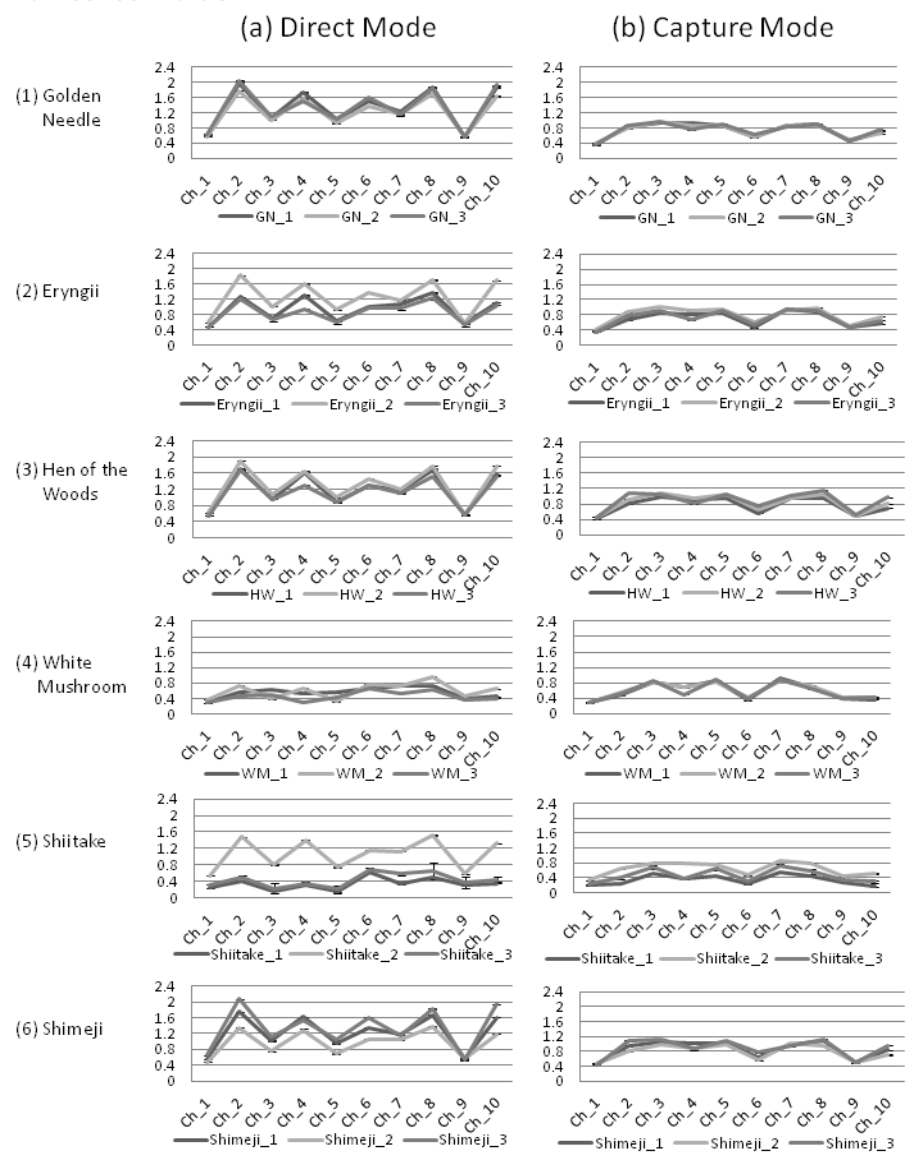
measurement methods, direct mode ( a ) and capture mode ( b ).